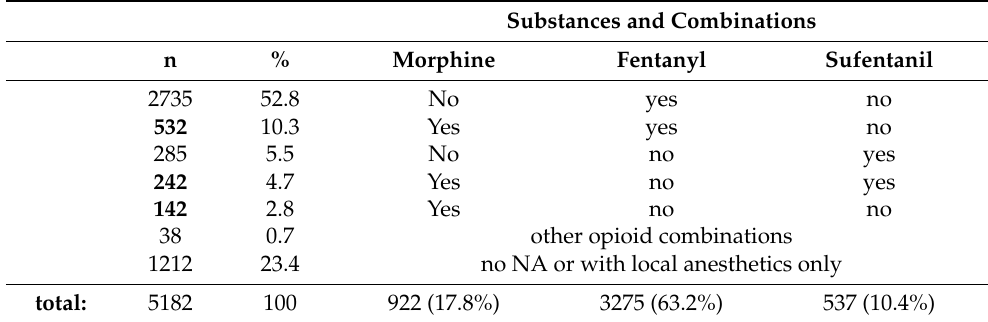
Table 2. Overview of opioids administered for neuraxial anesthesia (NA) The bold numbers listed in column “n” indicate the number of women who received